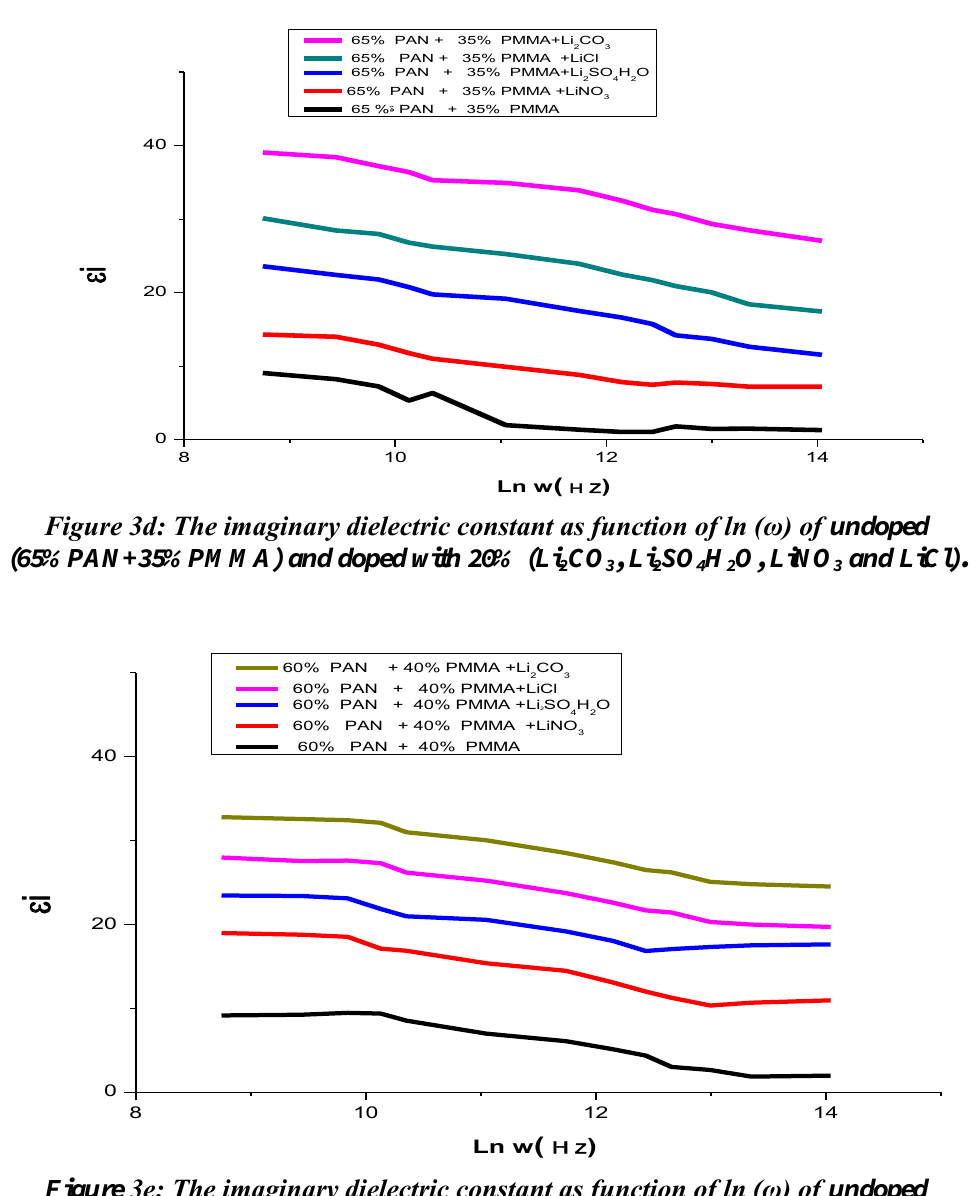
, LiCl, Li CO , and Li SO H 3 2 3 2 4 2